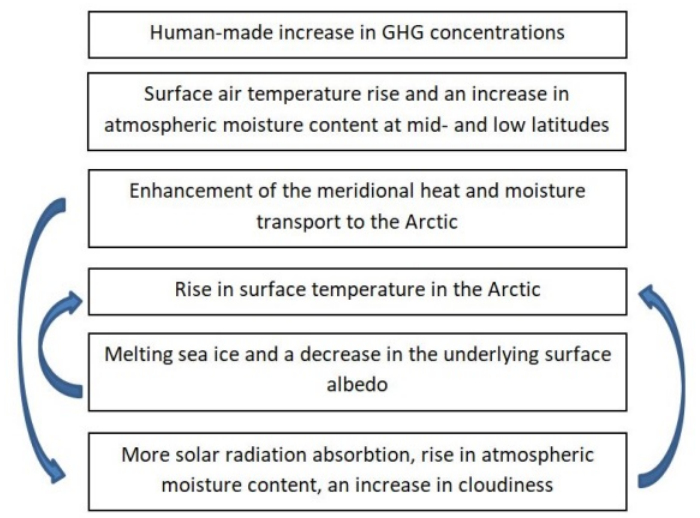
Figure 6. A simplified diagram of the Arctic climate formation.